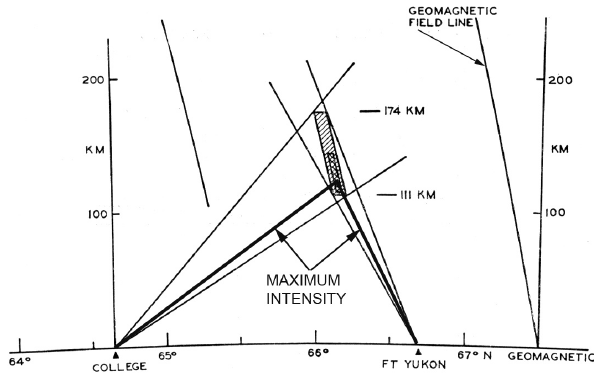
Fig. 3. Showing the method of locating the maximum 5577 ˚A [OI] intensity as triangulated from the two stations in the magnetic